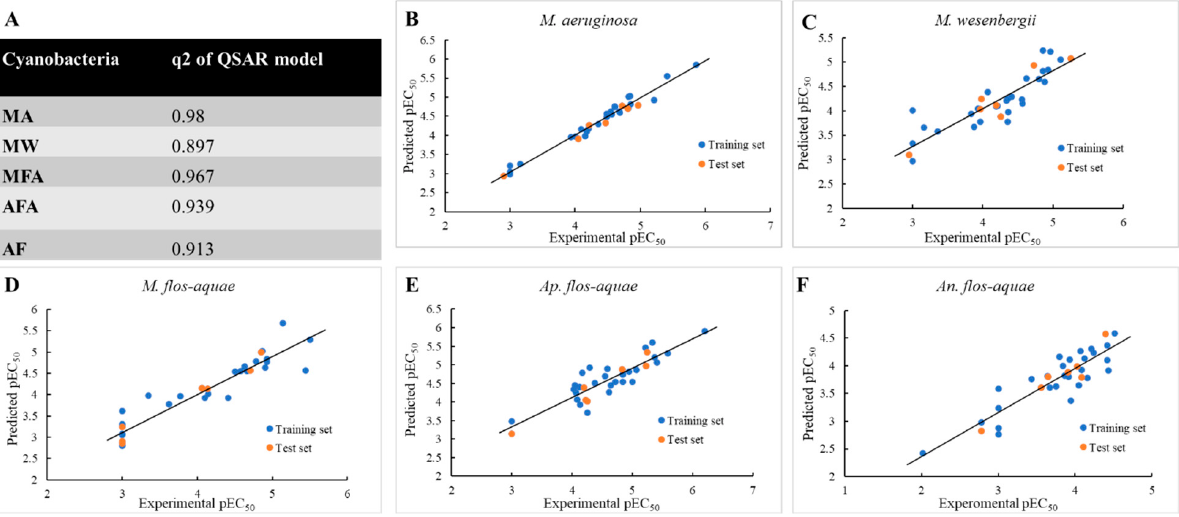
Figure 2. 3D-QSAR analysis results of compounds’ inhibitory effects on cyanobacteria. ( A ): q 2 values of all five 3D-QSAR models. ( B – F ): Plots of the predicted and experimental pEC 50 values of the training and test sets.